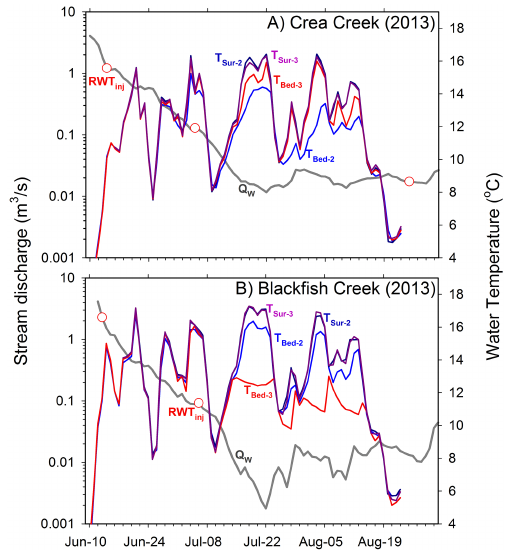
Figure 13. Streamflow hydrographs and temperature regimes for two beaded streams (Crea (a) and Blackfish (b) creeks) with con- trasting channel and watershed morphology. Bed and surface tem- peratures were monitored in multiple pools within each reach to document the timing, magnitude, and variation in stratification in relation to streamflow (streamflow is indicated by Q W , tempera- tures are indicated at pool beds by T bed and pool surface by T sur , and timing of water tracer injection studies are indicated with red circles by RWT inj ; all data are presented as mean daily values from hourly